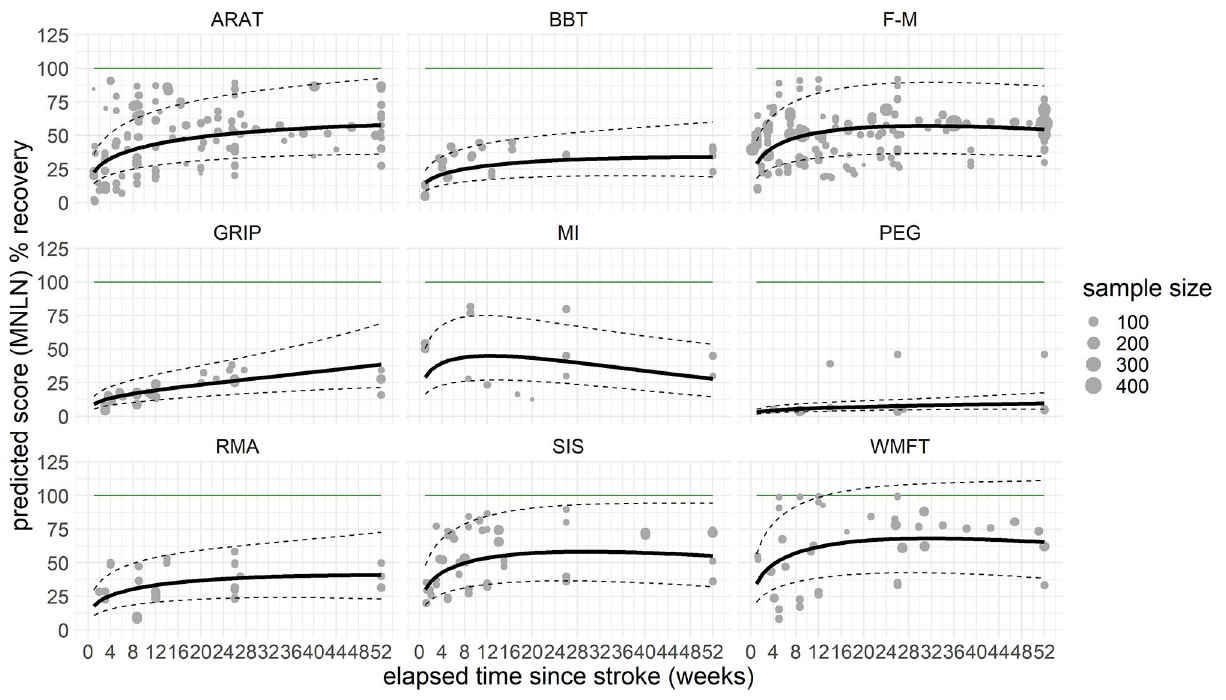
Frontiers in Neurology |